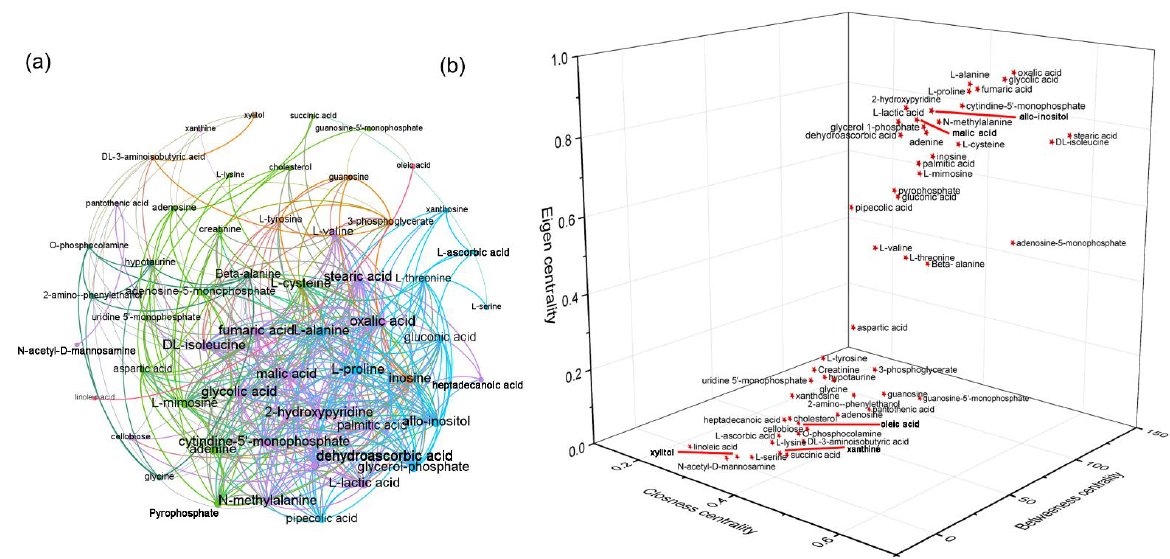
Figure 4. Hepatic metabolomics analysis. Metabolic correlation network analysis ( a ), and three-dimensional scatter plot of centrality indices of the correlation network ( b ). Pearson’s correlation coefficient (r) was used to construct the metabolic correlation network (using Gephi-0.9.2), and the threshold of the absolute correlation coefficient was set as no less than 0.5 at p -value less than 0.05.